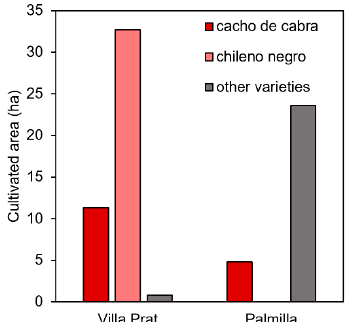
Figure 2. Land use in farms of chili pepper producers in Villa Prat and Palmilla, Maule, Chile.